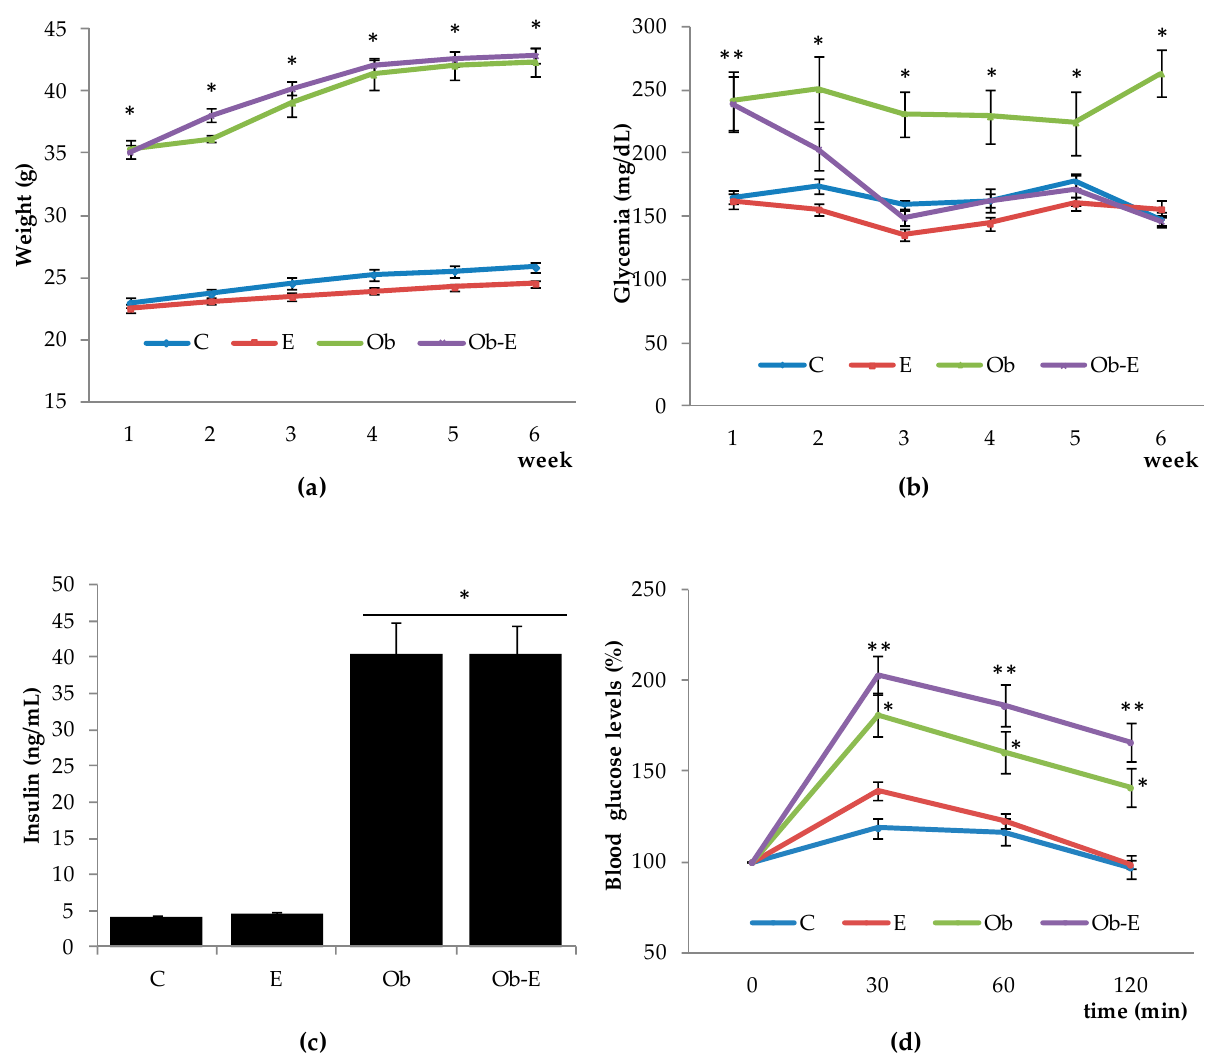
Figure 1. ( a ) Weekly animal weights (* p < 0.05 Ob-E and Ob vs. C and E); ( b ) weekly basal glycemia (* p < 0.05 vs. rest of groups, ** p < 0.05 vs. C and E); ( c ) blood insulin levels (* p < 0.05 vs. C and E); ( d ) blood glucose levels during the glucose overload test (%) (** p < 0.05 vs. all groups, * p < 0.05 Ob vs. C and E). C, wild-type control; E, wild-type ethanol; Ob, Ob control; Ob-E, Ob–ethanol.